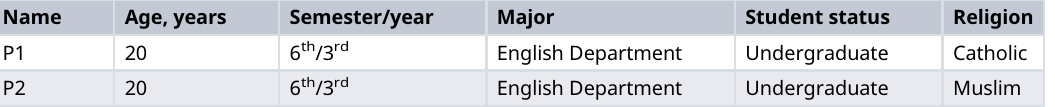
Table 1. Profile of